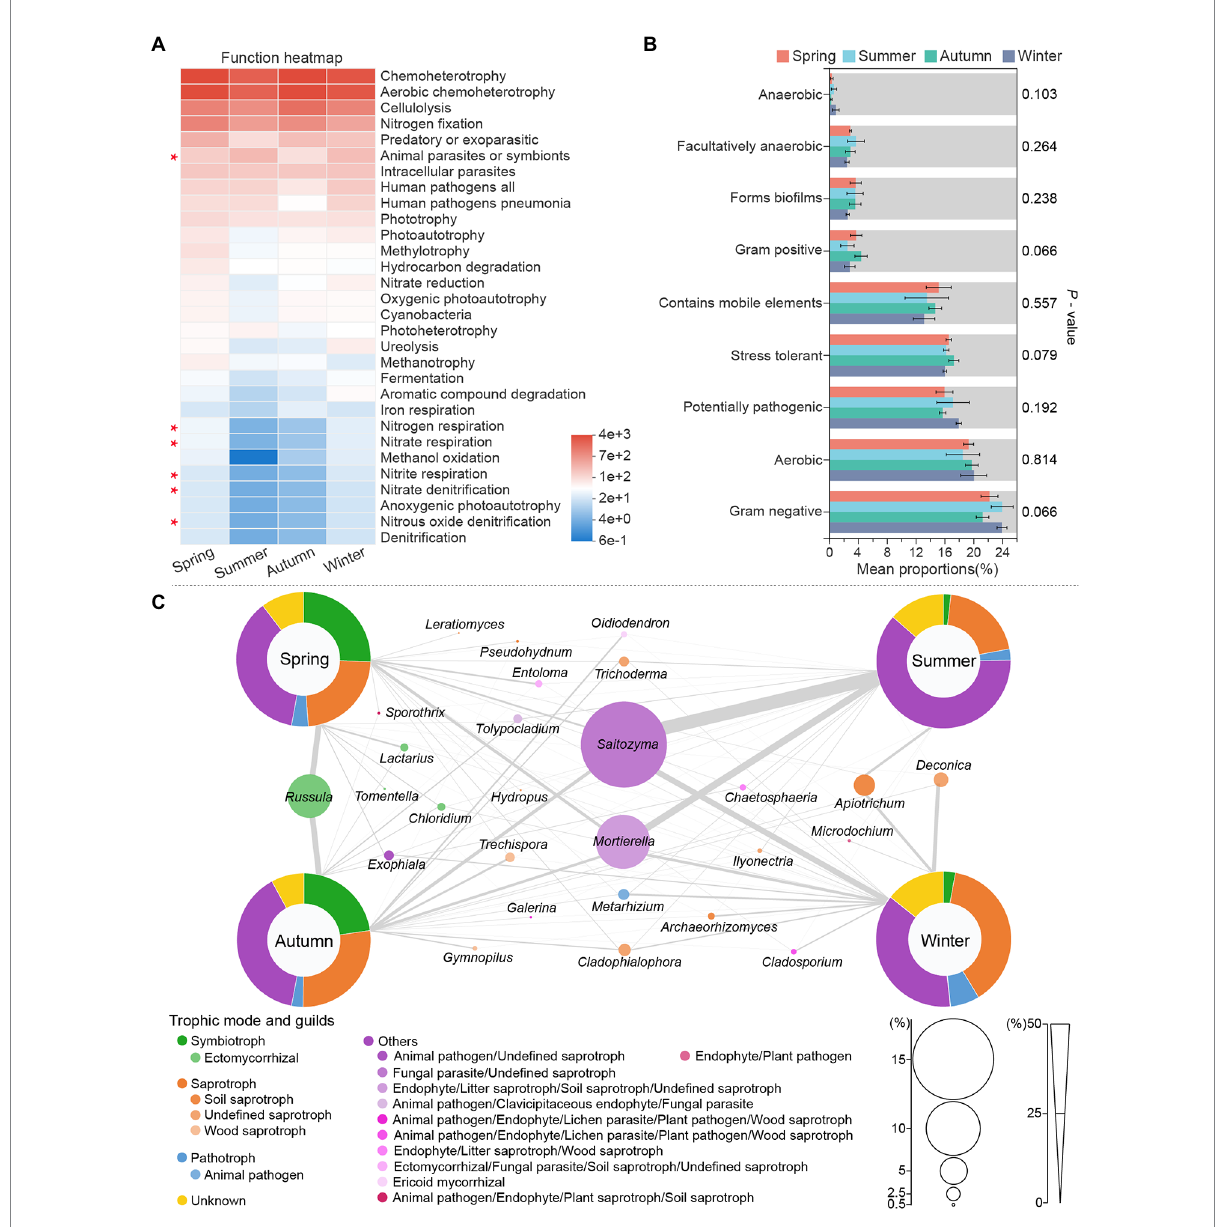
FIGURE 4 Functional prediction of rhizosphere microbes in C . pingbianense in four seasons. (A) Heatmap showing the top 30 bacterial ecological functions by total abundance in the samples. (B) Significant difference test among groups in bacterial phenotypes. (C) Fungal functional group composition of samples in four seasons. The size of circles in (C) reflected the total abundance of corresponding species in samples of all seasons, and the thickness of lines represented the abundance of that species in the sample of a certain